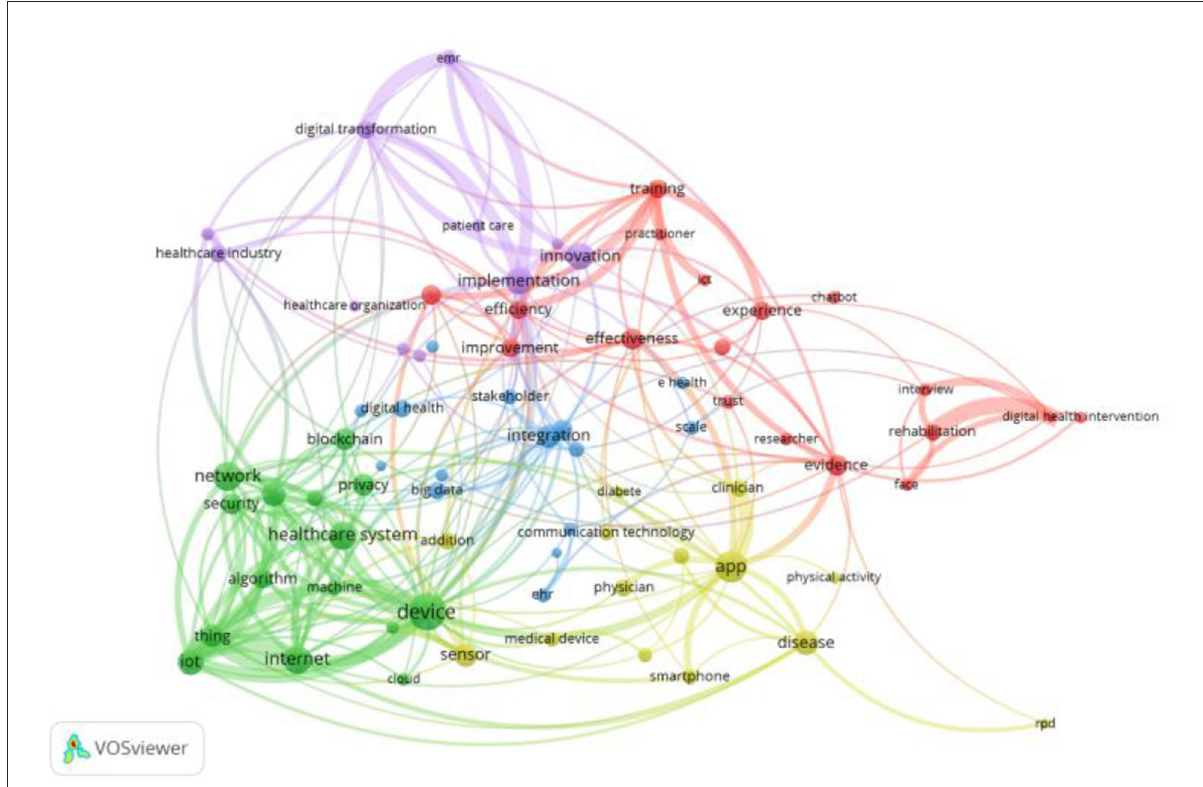
FIGURE4 Co-occurrence of